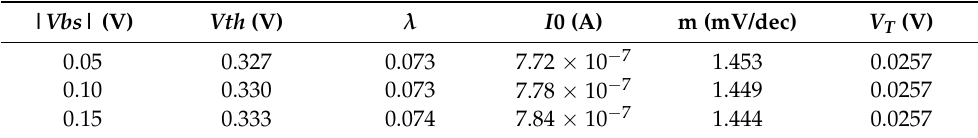
Table 14. Coefficients at different | Vbs | for NMOS (T = 25 ◦ C).